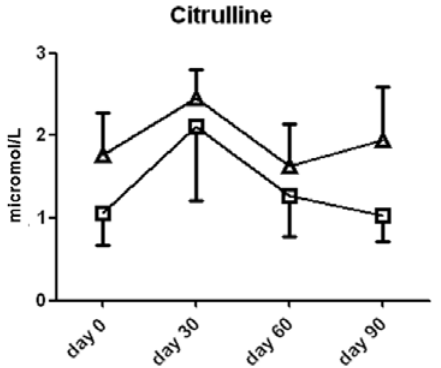
Figure 4. Citrulline content in serum from subjects treated with L -arginine (triangles) or placebo (squares). Data are presented as mean ±